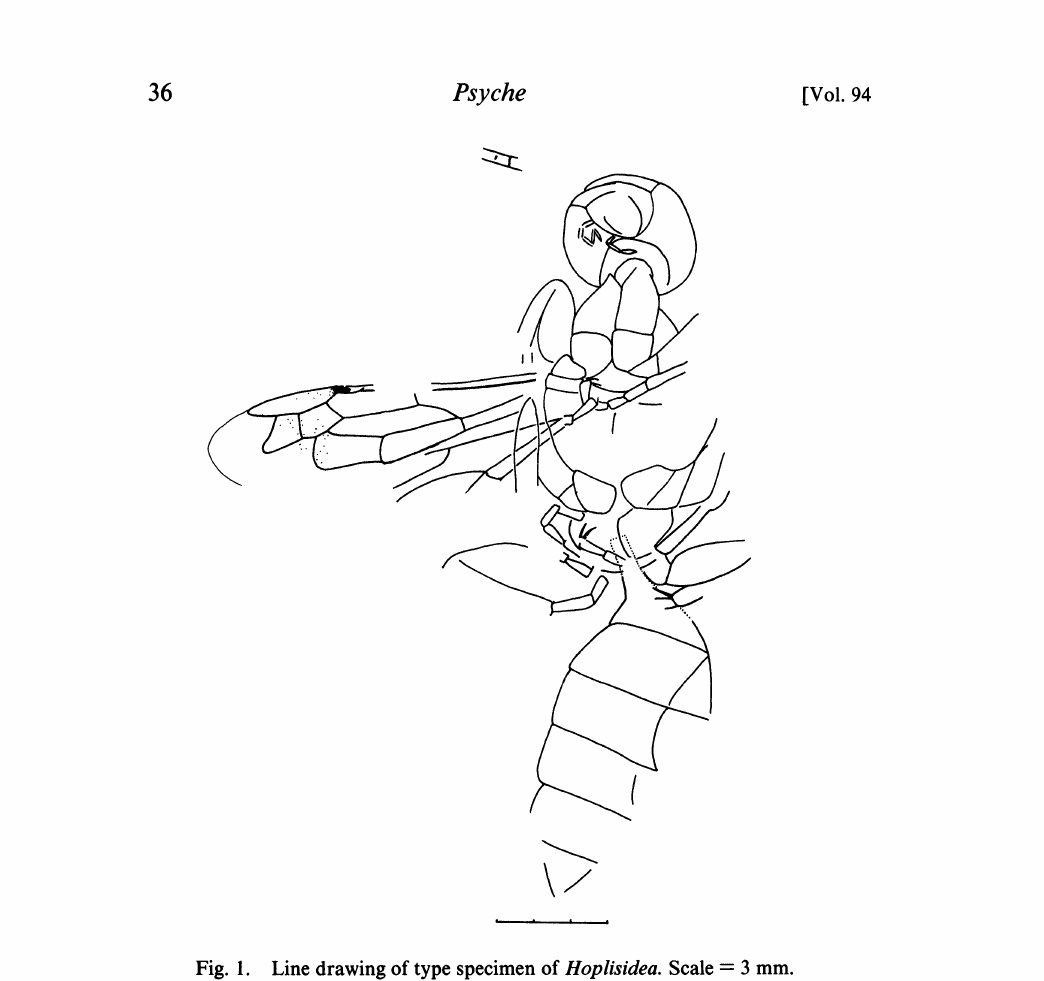
Fig. 1. Line drawing of type specimen of Hoplisidea. Scale 3 mm. lines on fig. indicate probable petiole configuration). Only 6 gastral segments can be distinguished, but it is uncertain whether the specimen is a